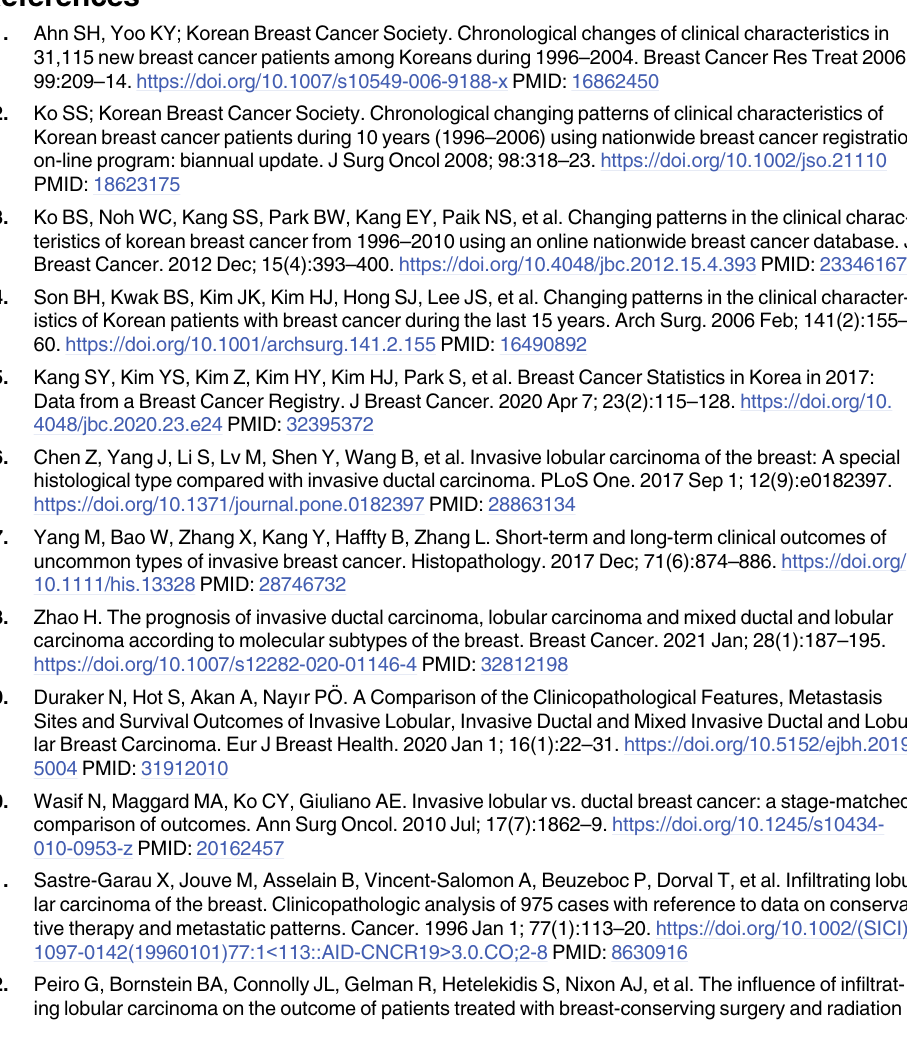
S1 Table. Inclusion/Exclusion criteria for patient